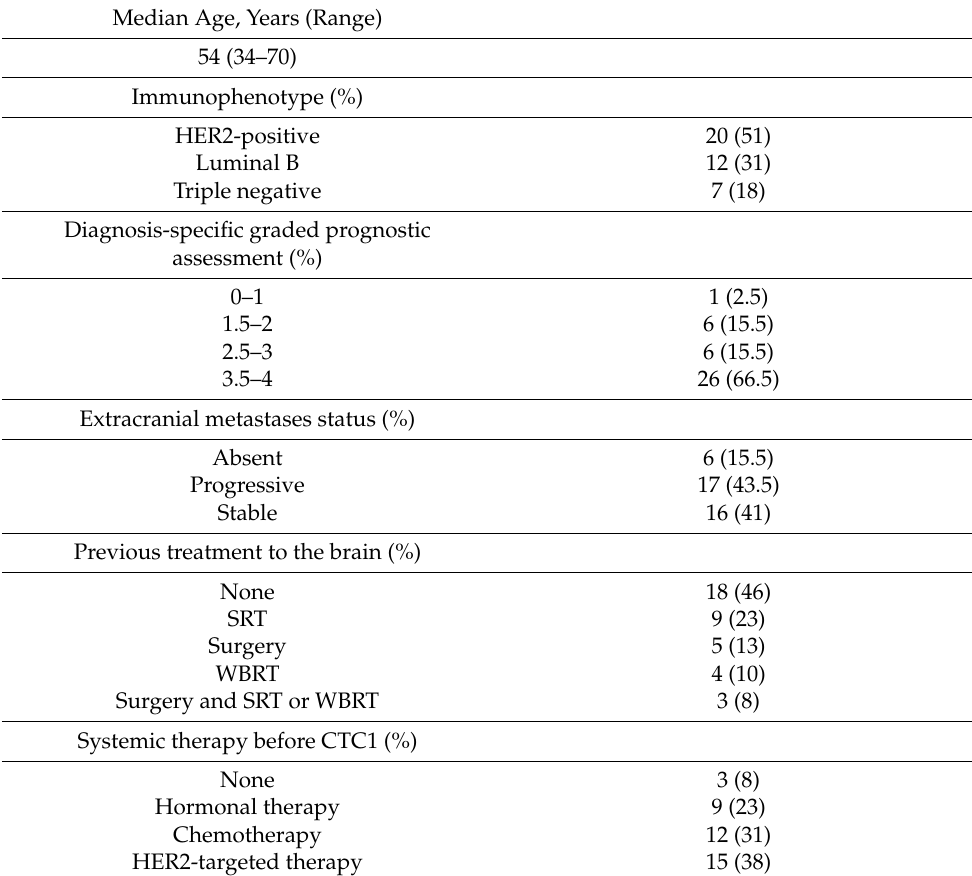
Table 1. Baseline